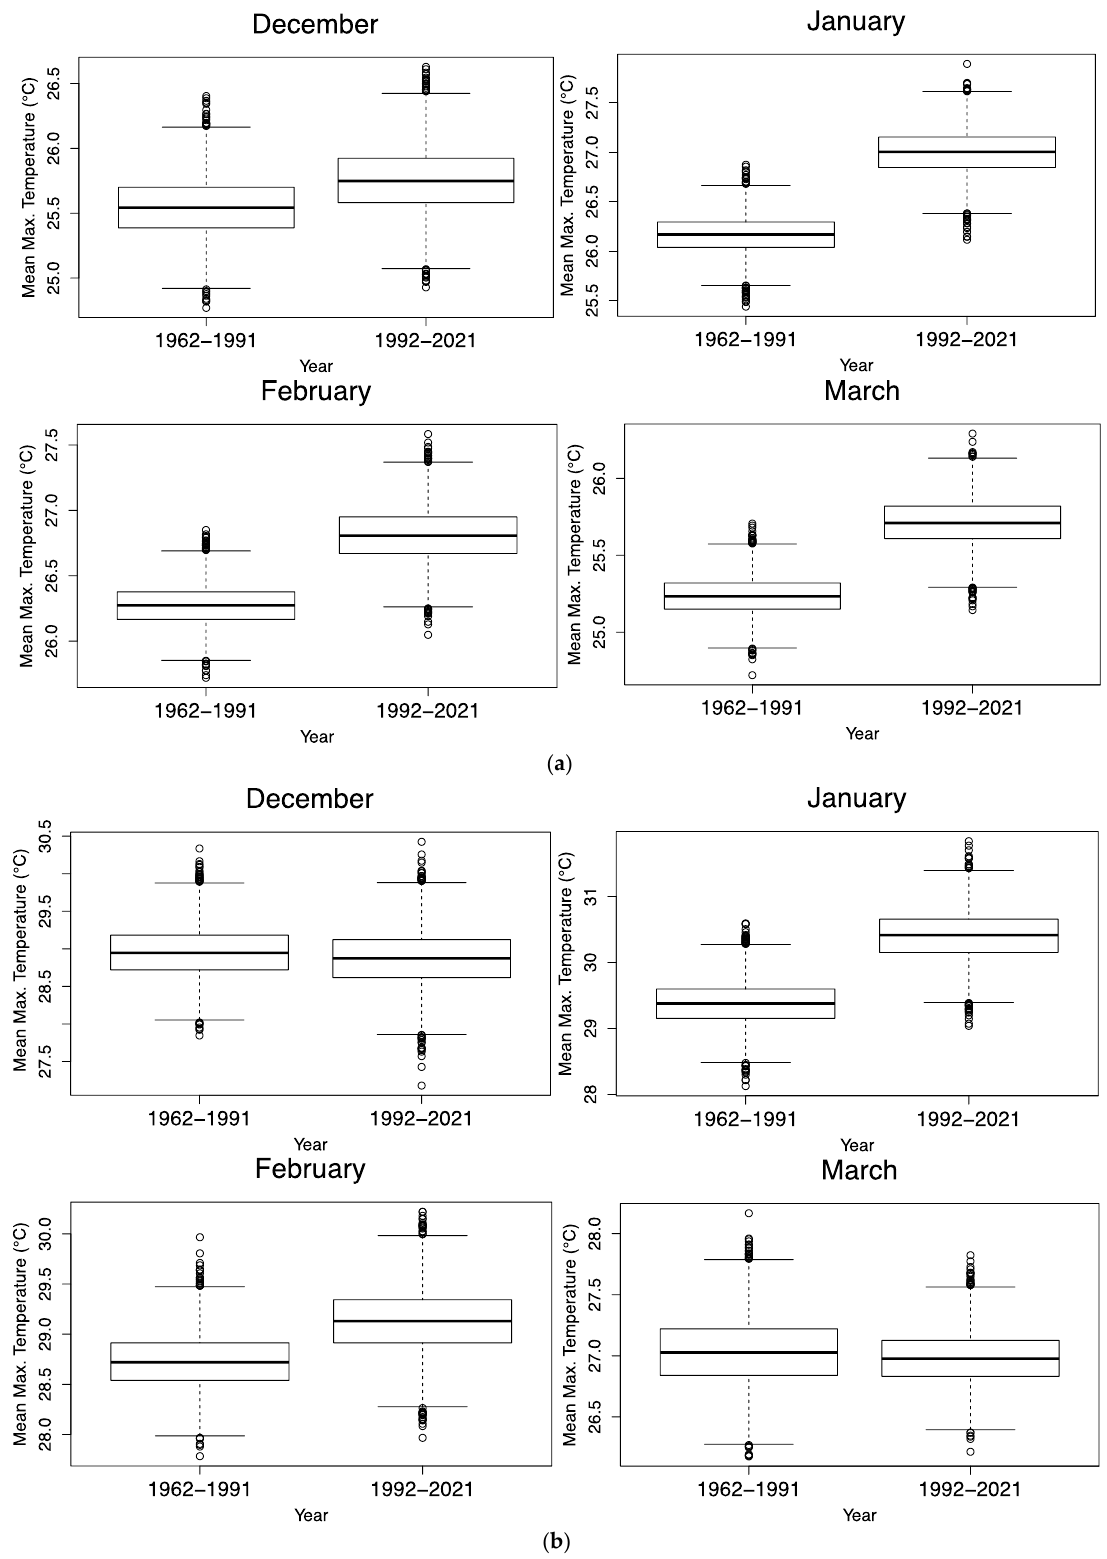
Figure 3. Box plots of the mean maximum temperature for each of the four summer months, December – March, grouped in the two climate periods, ( a ) Sydney, ( b )